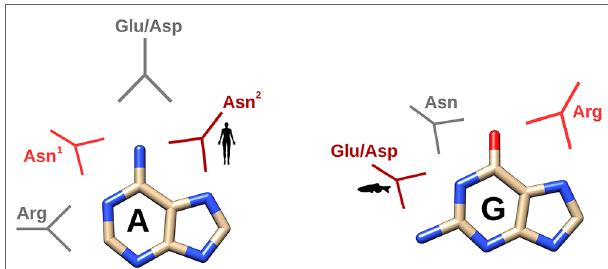
FIGURE 6 | Schematic depiction of the main interactions identified by molecular dynamics according to the two main family classes (mammalian versus non-mammalian RNases). In dark and light red, the main and secondary specific interactions characteristic for either mammalian or non- mammalian RNases and in grey, the other interactions observed in all the RNases analyzed. Representative icon labels for humans and fishes illustrate the predominant interaction mode for each RNase class. Asn 1 corresponds to Asn71 and Asn 2 to Asn 67 in RNase